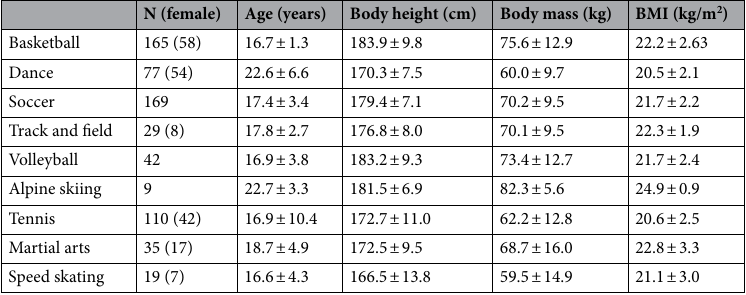
Table 1. Athlete characteristics (values are presented as means ± standard